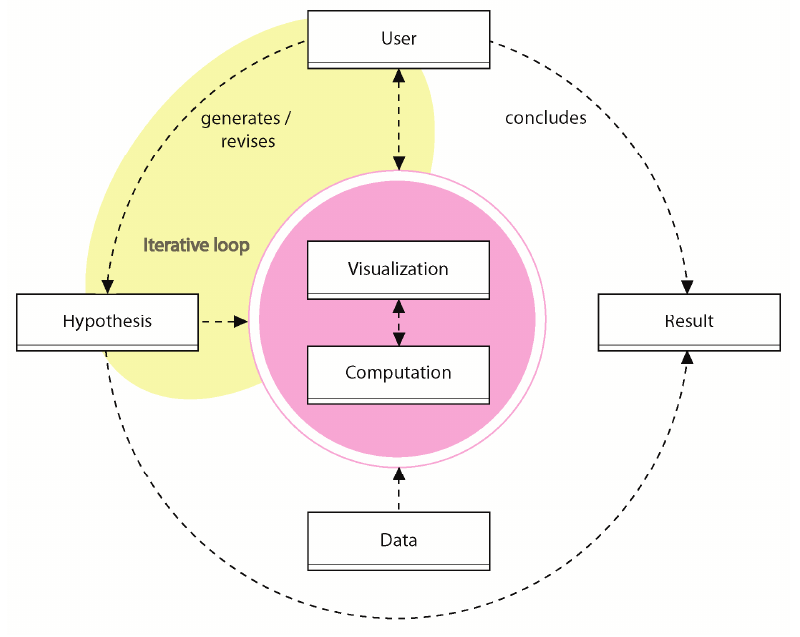
Figure 2. Basic concept of iterative analysis facilitating geovisual